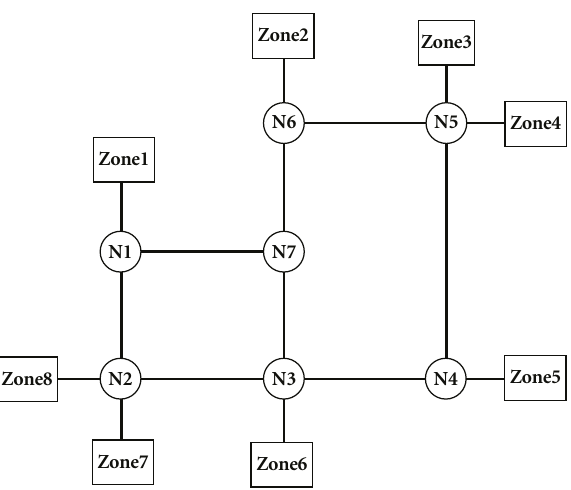
Figure 3: Sketch diagram of a practical road network in